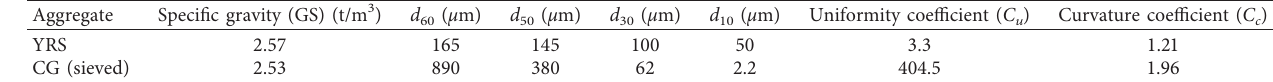
Figure 3: Particle size distribution curve of aggregate. Table 1: Main geotechnical properties of aggregate.